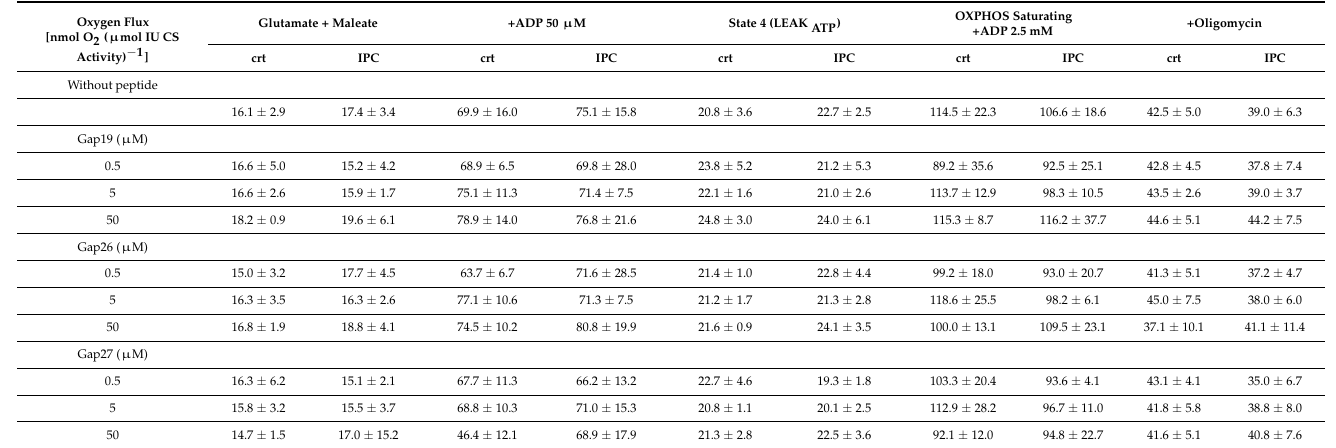
Table 1. Oxygen flux (nmol O 2 min − 1 normalized to CS activity µ mol IU min − 1 ).